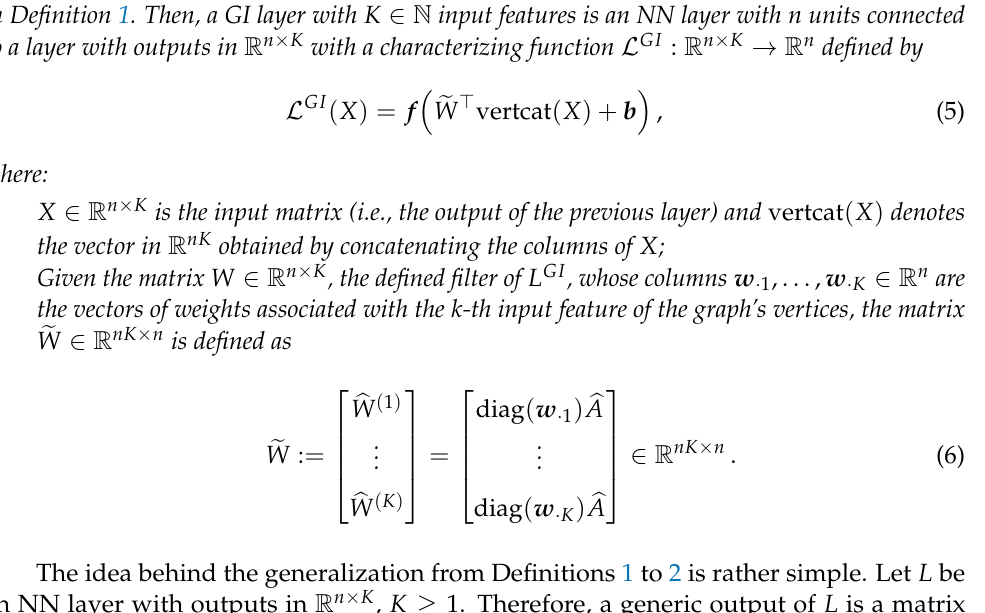
Figure 1. Case of non-directed graph with n = 4 nodes. Example of the action of a filter w “layer” of the plot) of a GI layer, applied to feature x 1 of the first graph-node v 1 , for the computation of x (cid:48) ; for simplicity, the bias is not illustrated. The orange edges describe the multiplication of feature 1 x i , of node v i , with the filter’s weight w i , for each i = 1, . . .